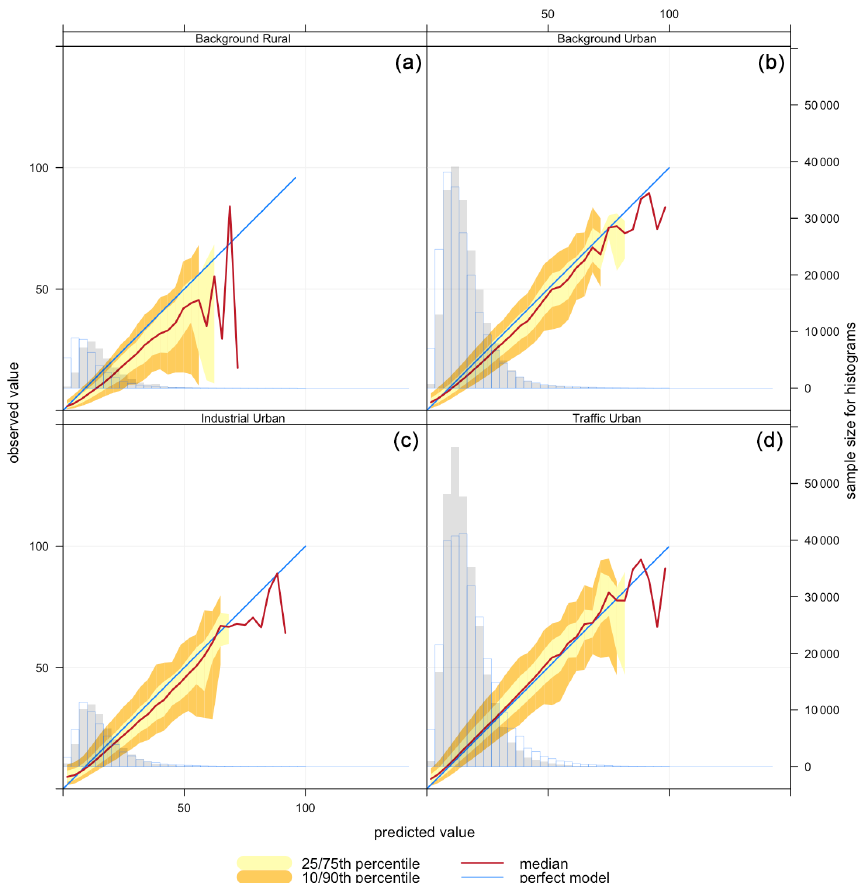
Figure 11. Conditional quantile plot of modelled and observed pollutant concentrations of PM 10 based on model 6 (Median) for station environmental types: (a) background rural, (b) background urban, (c) industrial urban, (d) traffic urban.